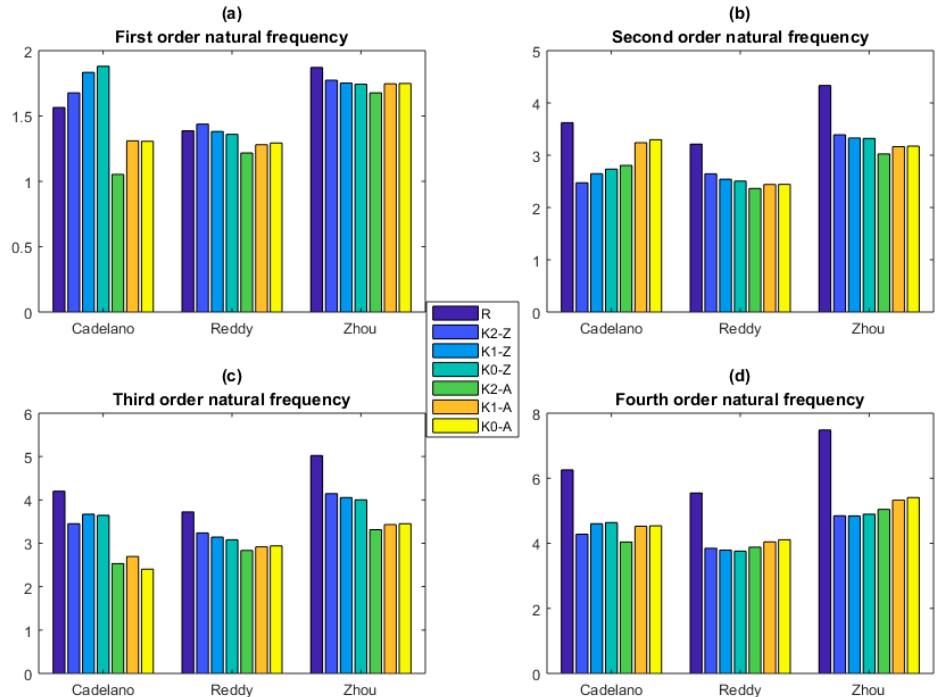
Figure 8. Comparison between the prediction results of KSM and that of MM (the unit for the natural frequency is THz. K0–K2 are for the constant, linear, and quadratic functions. Z and A are for Zigzag and Armchair graphene sheets, respectively. ( a ), ( b ), ( c ) and ( d ) are the first four order natural frequencies, respectively.).